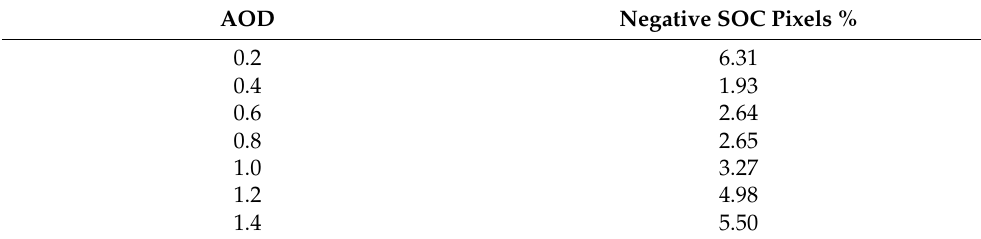
Table 6. Percentage of negative SOC estimated using Hyperion data corrected by FLAASH, from both the sites.